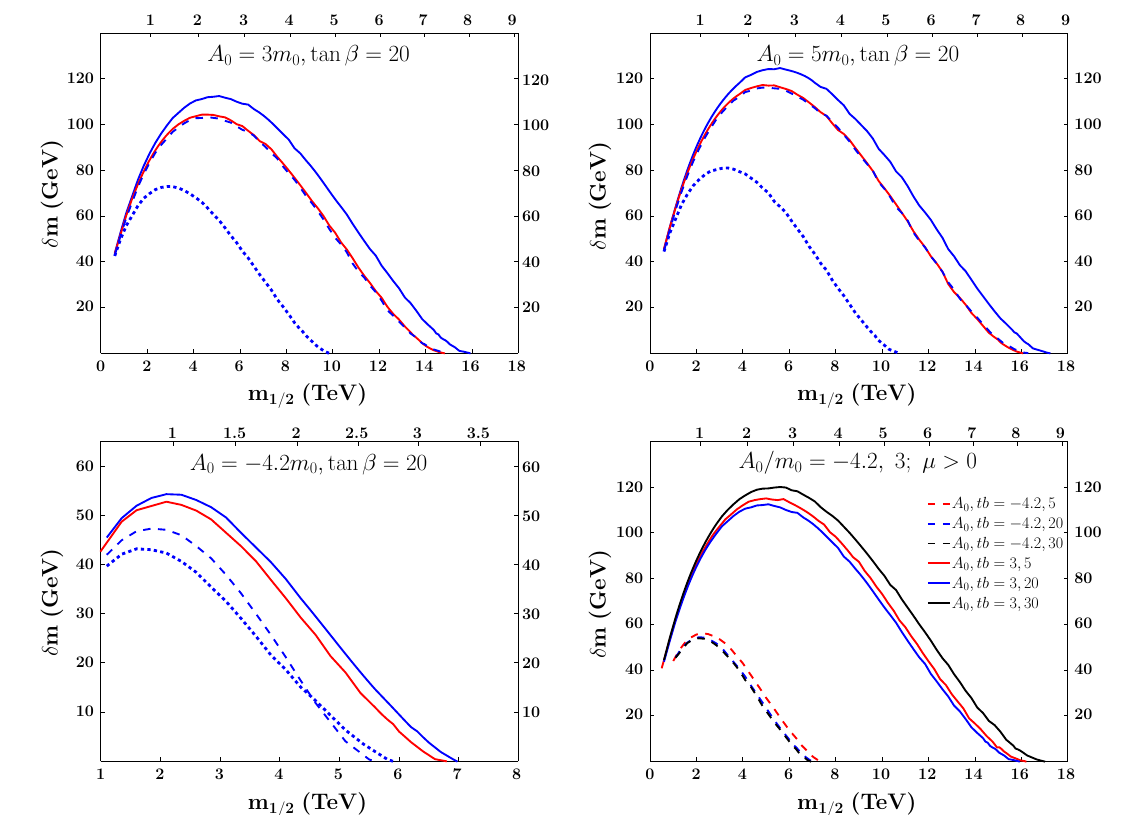
dashed line excludes only the bound-state effects, and the dotted line excludes only scatterings to WW / Z Z . The lower right panel compares results of tan β = 30 (black), 20 (blue) and 5 (red) for A 0 = 3 m 0 (solid lines) and for A 0 = − 4 . 2 m 0 (dashed lines)